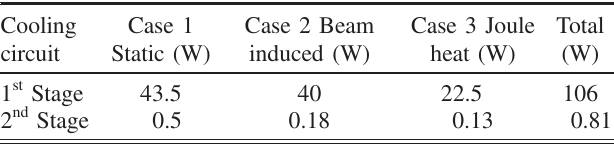
TABLE III. Predicted heat loads on the HSCU cooling